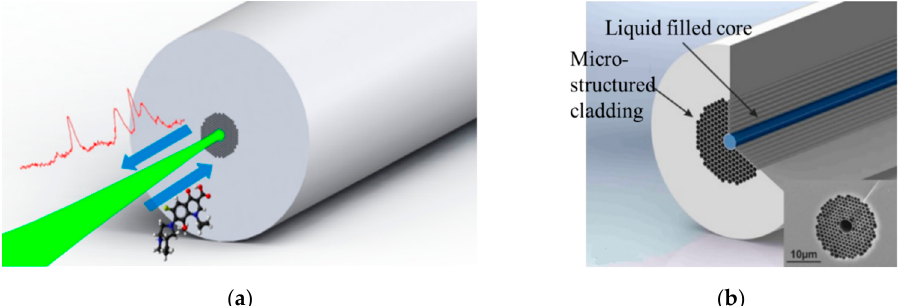
Figure 8. Raman detection principle diagram of hollow core photonic crystal fiber. ( a ) Raman light is generated by the interaction between the substance and the laser in the HCPCF. The green represents the laser transmitted in the central hole, and the red represents the Raman spectrum. ( b ) A cross-sectional view of a hollow core photonic crystal fiber selectively filled with a central hole. Reprinted with permission from [53]. Copyright (2017) American Chemical Society.